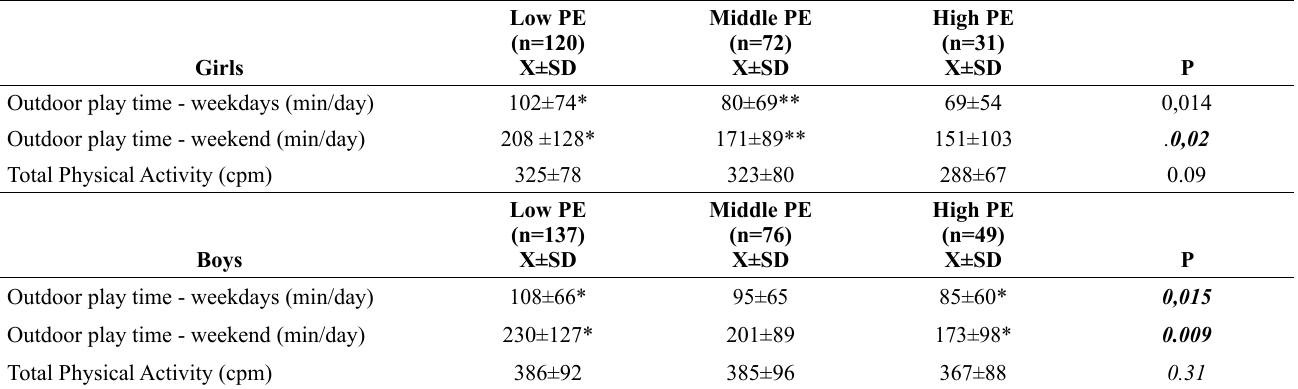
Table 2 – Differences in playing outdoor at weekdays and weekends as well as total physical activity according to parental education status